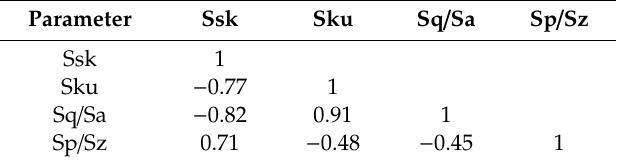
Table 1. The values of the linear correlation coefficient, r, among surface texture parameters.